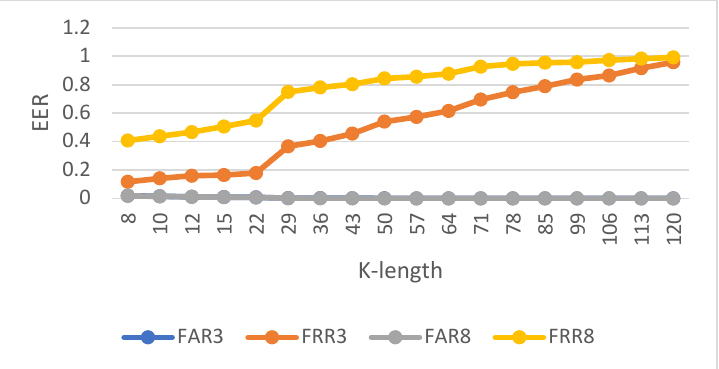
Figure 4. The result of EER on the BioIdent dataset with respect to K-length with first scenario. FAR3 and FRR3 for three enrollment samples, FAR8 and FRR8 for eight enrollment samples.